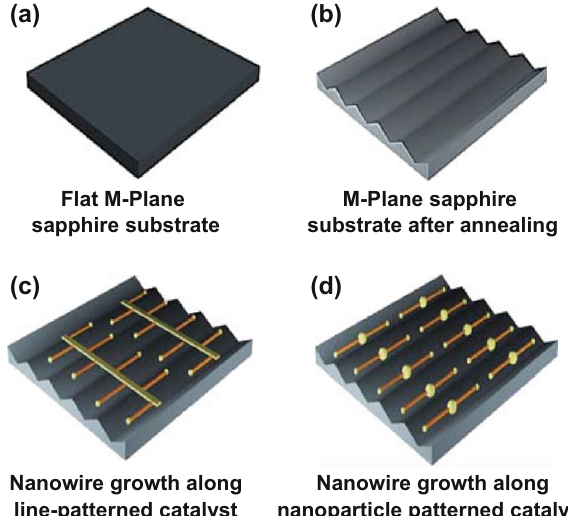
Fig. 1 Growth schematic for the in-plane-directional CdS x Se 1 - x NWs. a M -plane sapphire substrate surface before annealing. b M - plane substrate surface with V -shape grooves after high temperature annealing. c – d VLS growth of NWS along the pre-defined Au catalyst